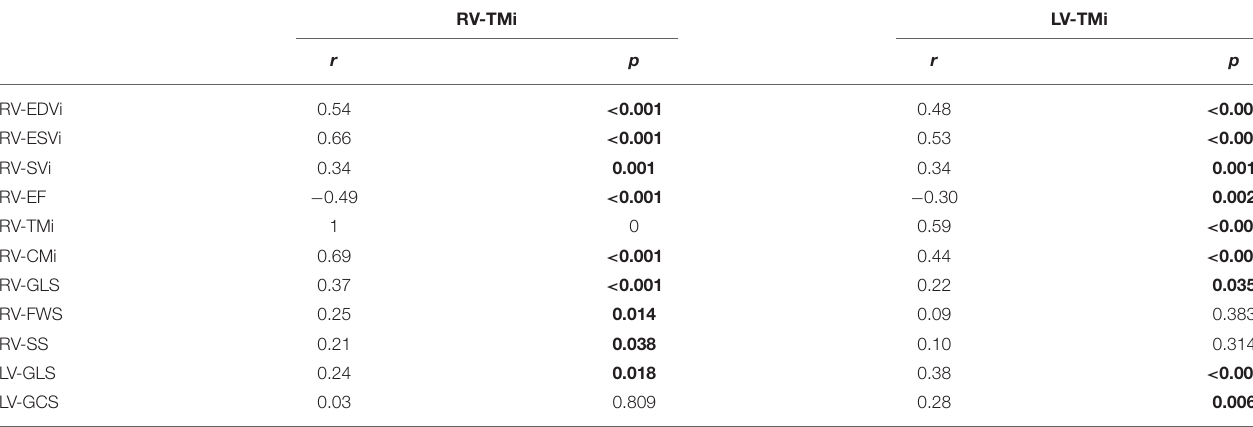
TABLE 3 | Correlation between right and left ventricular trabecular mass index and right ventricular parameters and left ventricular global strains.